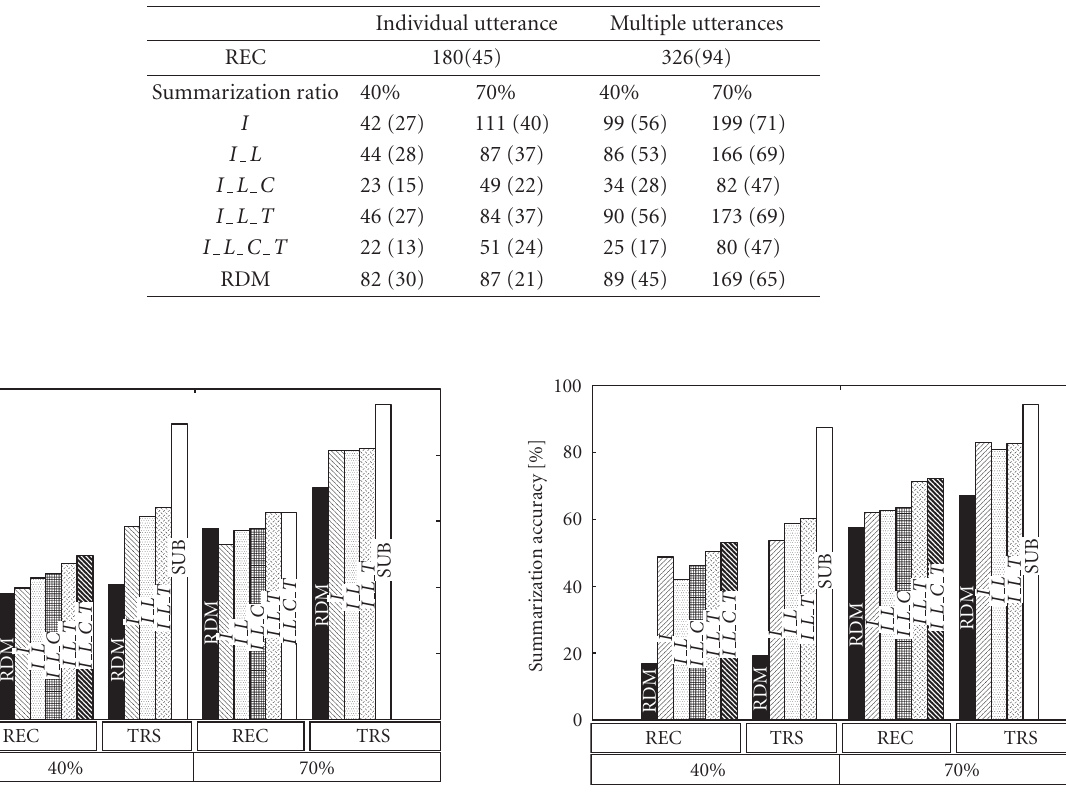
Figure 10: Article summarization at 40% and 70% summarization ratios. REC: summarization of recognition results, TRS: summa- rization of manual transcriptions, RDM: random word selection, C : confidence score, I : significance score, L : linguistic score, I L